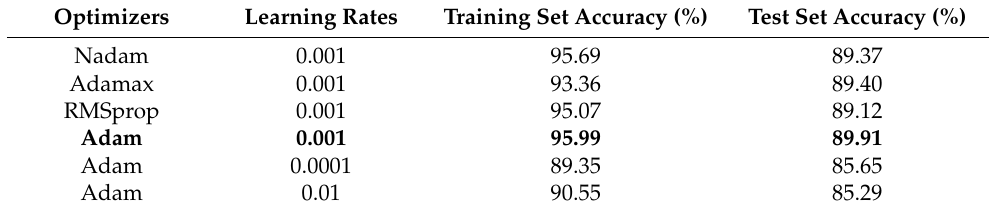
Table 5. Different optimizers and learning rates debugging results.